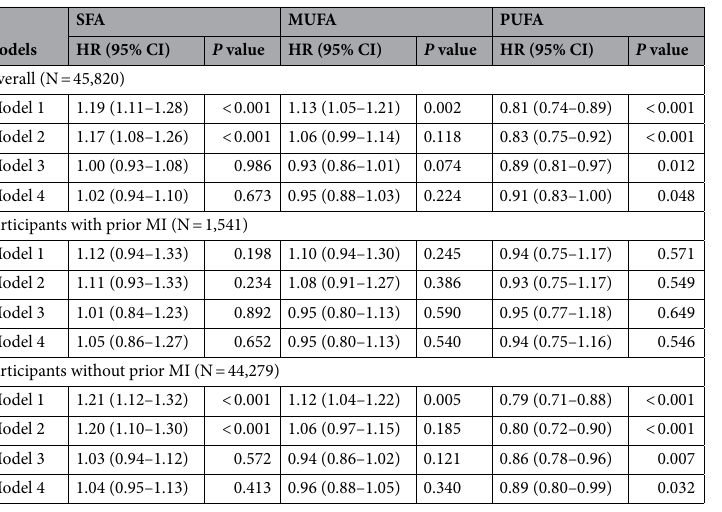
Table 2. A 5% higher calorie intake from usual intake of fatty acids and risk for heart disease mortality among 45,820 adults. Model 1: adjusted for age; Model 2: adjusted for age, sex, and ethnicity; Model 3: adjusted for age, sex, ethnicity, obesity, poverty-income ratio, education, physical activity, alcohol consumption, smoking status, survey period, usual intake of protein (natural log transformed), and usual intake of carbohydrate (natural log transformed); Model 4: adjusted for all the factors in Model 3 plus systolic blood pressure (natural log transformed), total cholesterol (natural log transformed), and hemoglobin A 1c (natural log transformed). CI Confidence interval, HR Hazard ratio, MI Myocardial infarction, MUFA Monounsaturated fatty acid, PUFA Polyunsaturated fatty acid, SFA Saturated fatty